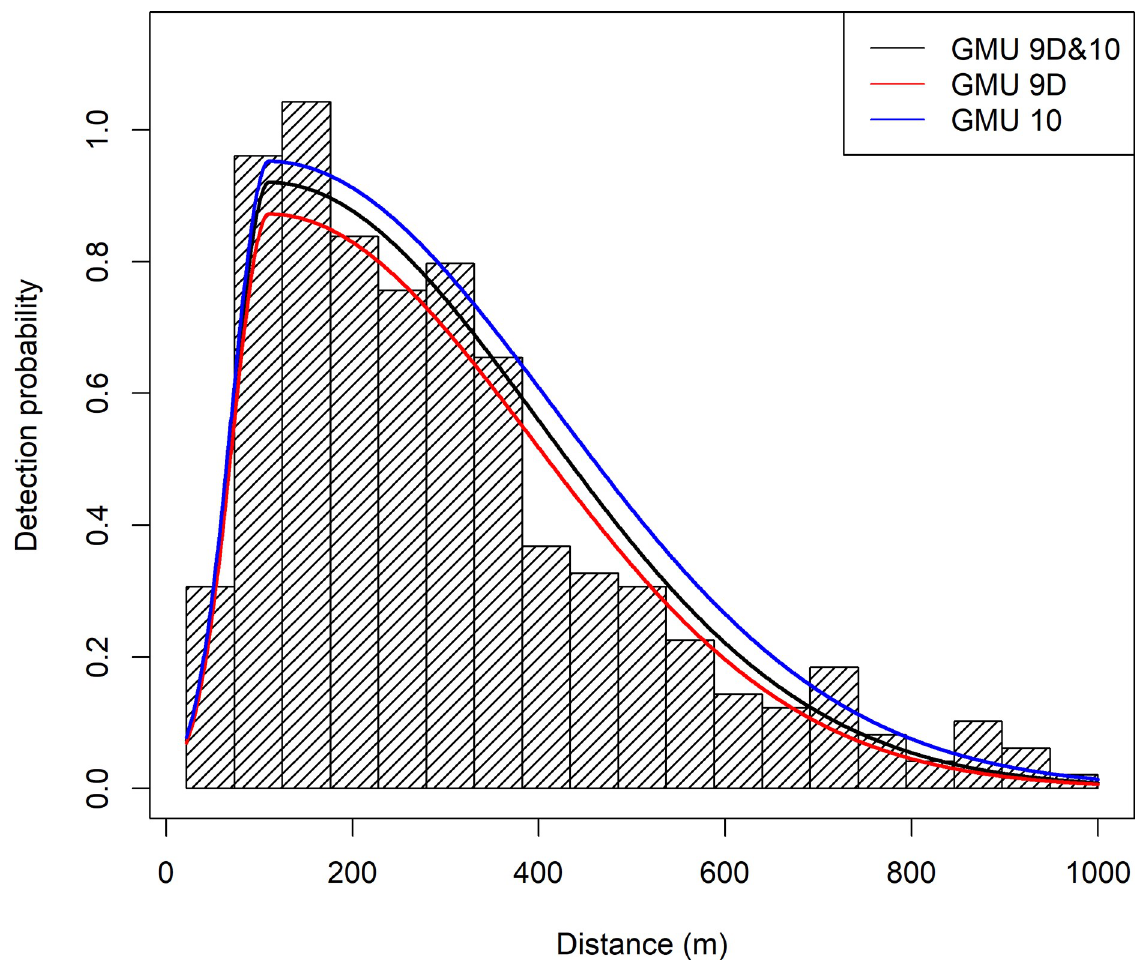
Fig 4. Estimated average detection of brown bears from a spring 2002 line-transect survey of Game Management Unit (GMU) 9D, GMU 10, and for GMUs 9D, and 10 combined, Southwest Alaska. Average detection for the multiple covariate distance sampling model was the mean of the observed covariate values for covariates used in the model applied to their model coefficients. For the mark-resight model, a weighted average of the covariates [2, eq 17) was used to calculate average apex detection, which was used to rescale the graph. The histogram is for the combined GMU 9D and 10